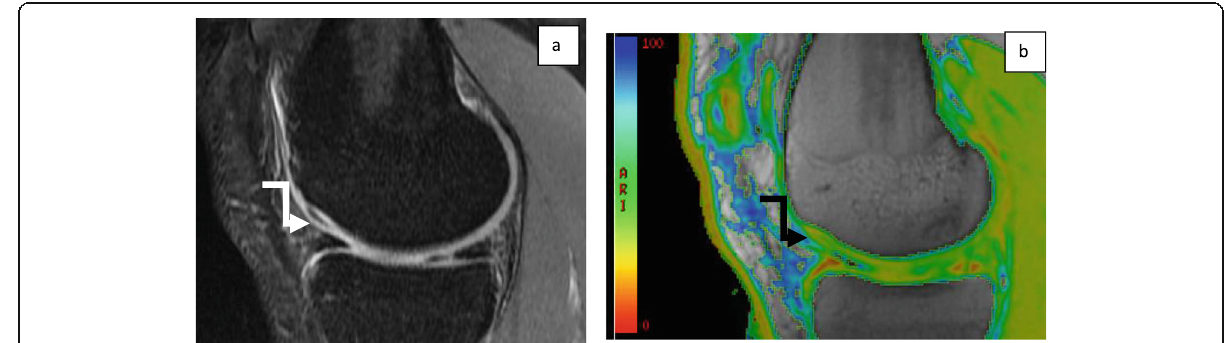
Fig. 3 Preserved bright hyperintense signal of cartilage covering the medial tibiofemoral condyle with average uniform cartilage thickness (arrow) ( a ). Elevated color-coded values of cartilage (superficial zone (aqua) and deep zone is normal (red, yellow, or green)) covering the medial tibio- femoral condyle ICRS grade 2(arrow) ( b )